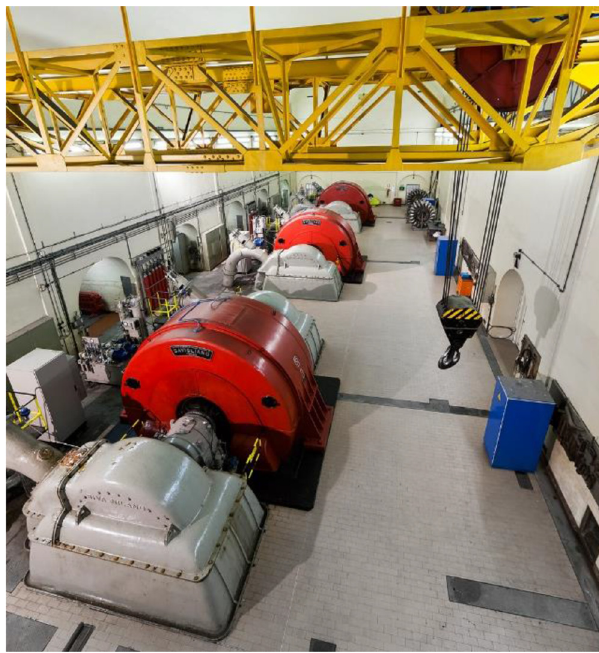
Fig. 1. A picture of the Signayes Hydropower Plant from C.V.A.